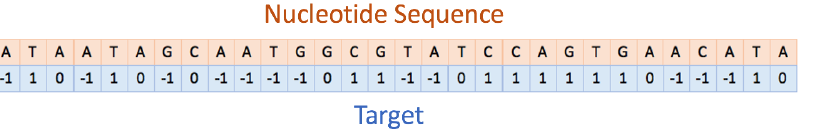
Figure 4. Part of a consensus sequence (computed for rsxC) indicating the nucleotides situated within fast (labelled with − 1) and slow (labelled with + 1) translation regions. On nucleotides labelled with 0, no reproducible results have been obtained